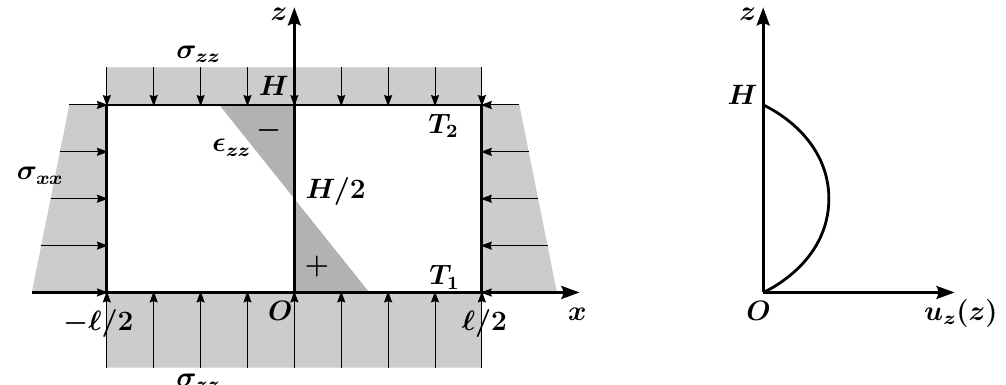
Figure 1. Illustration of the strain (cid:101) zz , stress σ and displacement u z induced by a temperature gradient. Initially, the temperature is uniform T = T 2 throughout the viscoplastic fluid